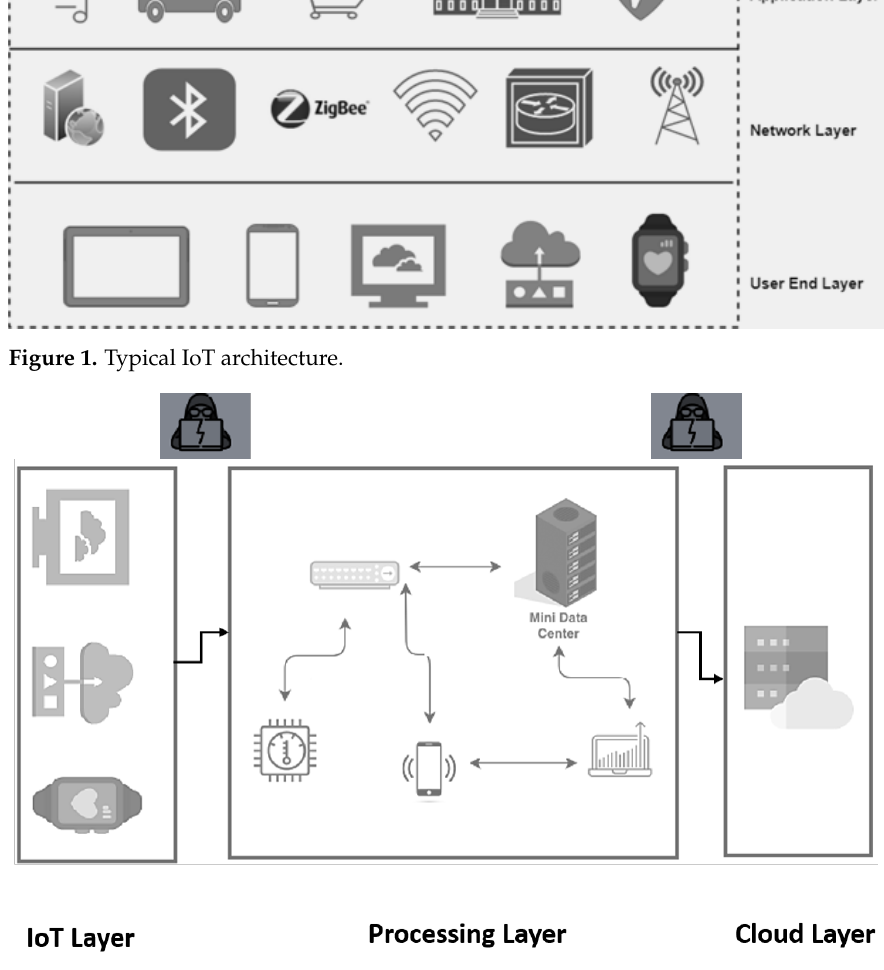
Figure 2. IoT-based cloud attack